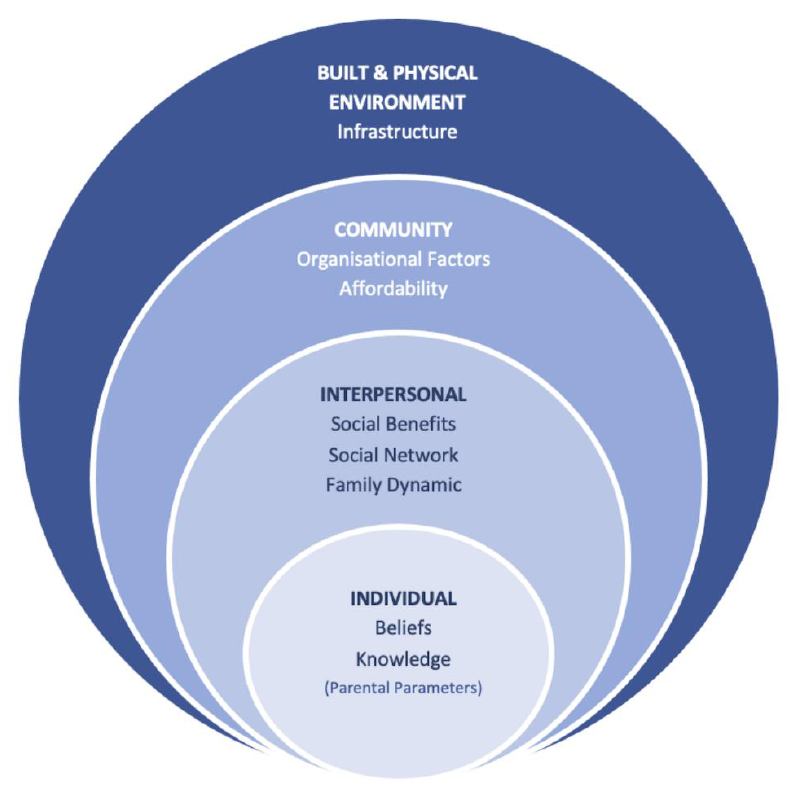
Figure 2. Socio-ecological model of factors that influence parental engagement of pre-school children in community-based opportunities for physical activity.